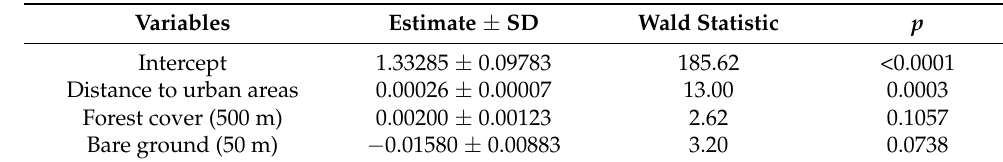
Table 4. Results of the best linear regression model explaining bird abundance (log-transformed) in drove roads as a function of variables at the landscape and drove road scales. Variables Estimate ± SD Wald Statistic p Intercept 1.33285 ± 0.09783 185.62 <0.0001 Distance to urban areas 0.00026 ± 0.00007 13.00 0.0003 Forest cover (500 m) 0.00200 ± 0.00123 2.62 0.1057 Bare ground (50 m) − 0.01580 ± 0.00883 3.20